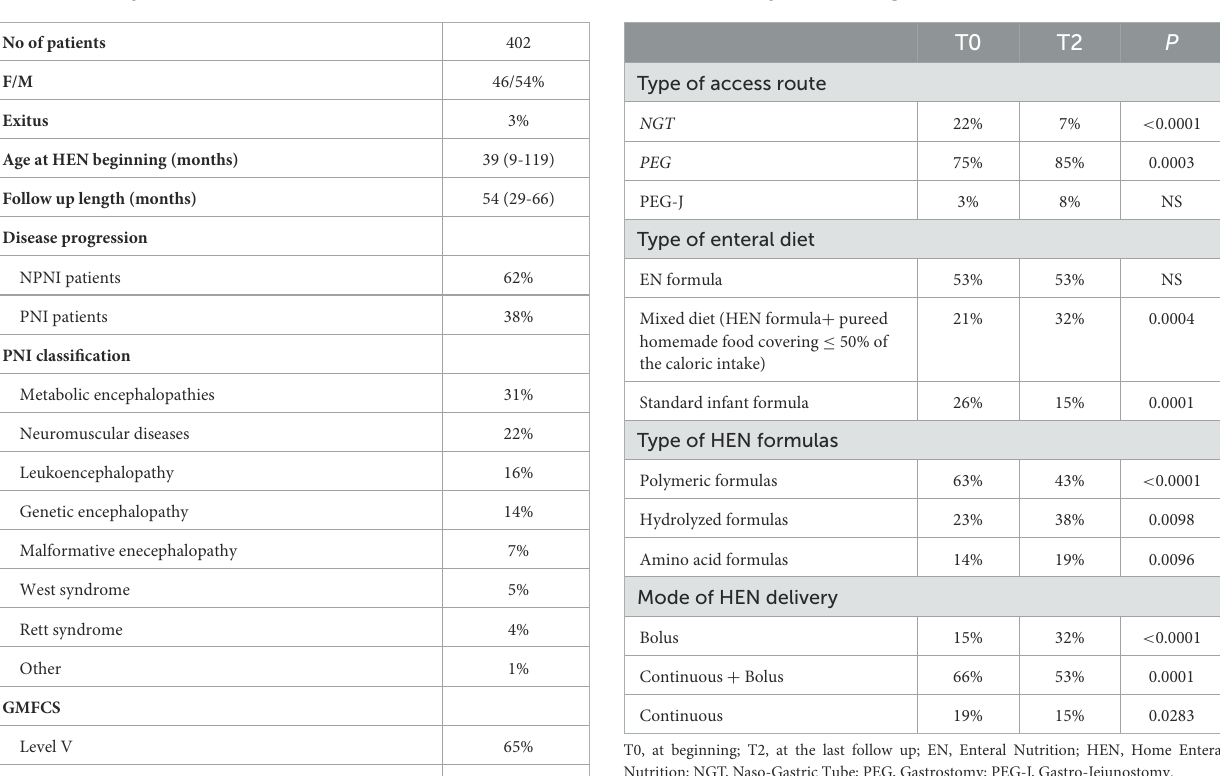
TABLE 2 Summary of the main characteristics. TABLE 3 Summary of HEN management.